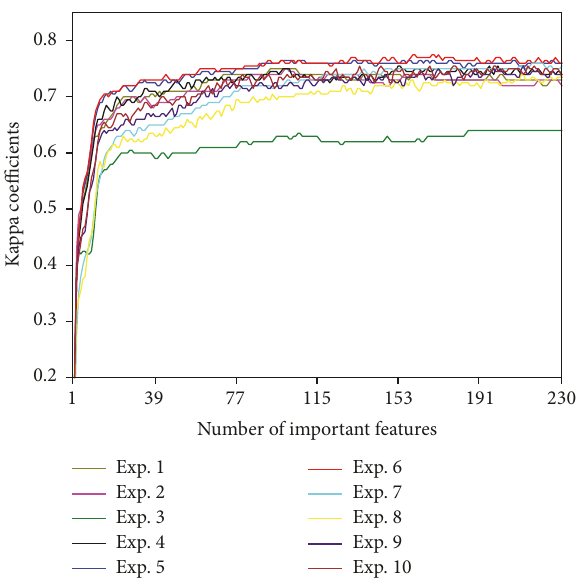
Figure 2: Variation of the kappa coefficient by increasing the number of input features.